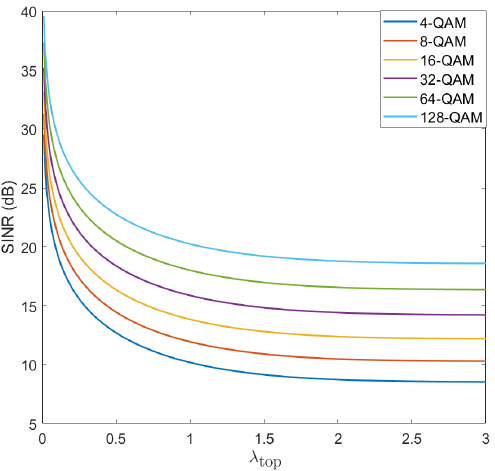
Figure 6. Impact of MCC-OFDM clipping on required SINR for target